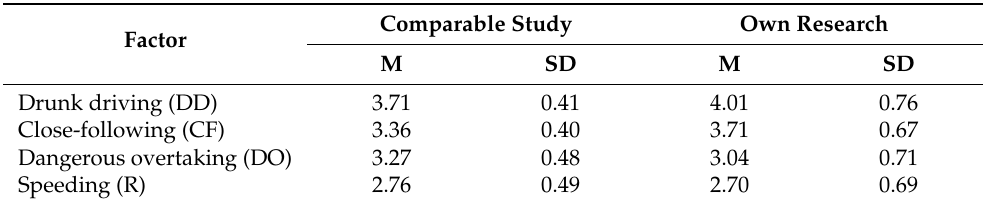
Table 3. DAQ results and comparison with a foreign study. Abbreviations: M = arithmetic mean; SD = standard deviation. Source: [37], processed by authors.